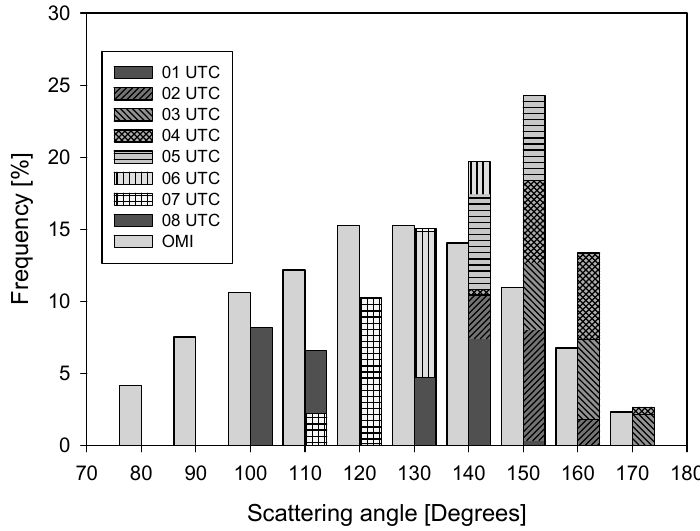
Figure 1. Frequency distribution of the scattering angle of GEMS and OMI over the GEMS coverage range. The frequency is calculated using the actual sun- and satellite-geometry of OMI measurements and numerical calculations of the expected GEMS ground pixel per day for each month during 2006. Patterns indicate the frequency at each observation time of the GEMS. Tick values on the x -axis are the minimum value of each bin.